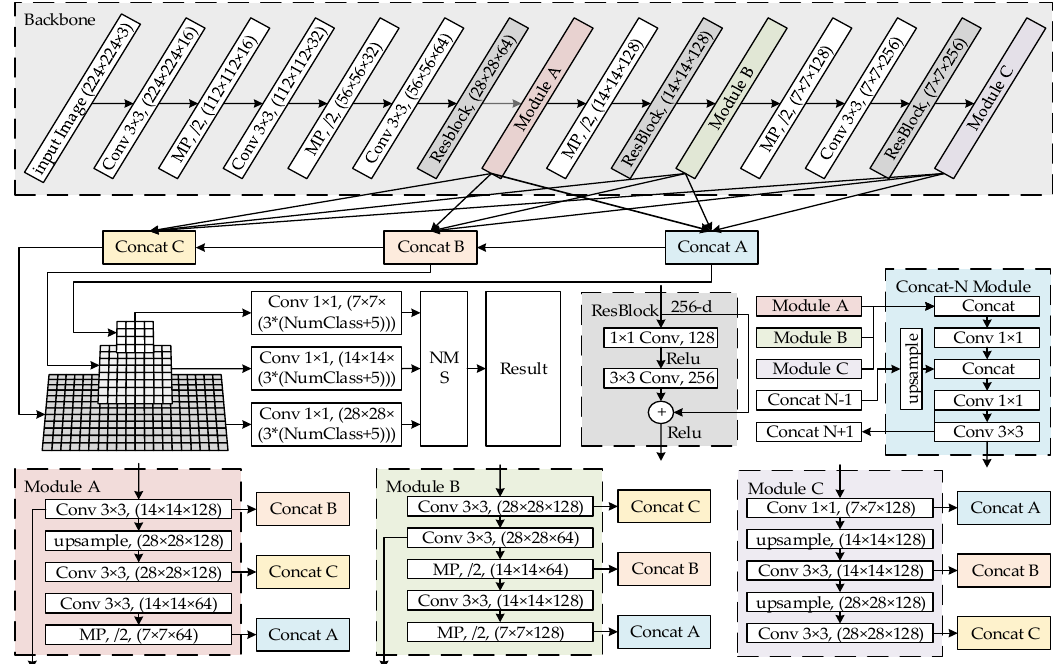
Figure 2. Mixed YOLOv3-LITE network structure.